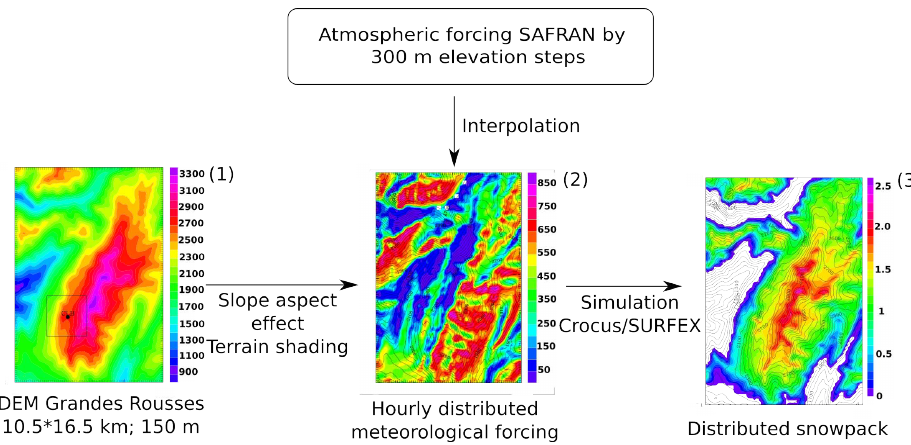
Fig. 7. Flow chart of the distributed simulation over the Grandes Rousses range. (1) DEM Grandes Rousses (150m) (2) Incoming shortwave radiation (diffuse+direct, Wm 2 ) on 2011/02/18 10:00 (3) Snow depth (m) on 2011/04/15